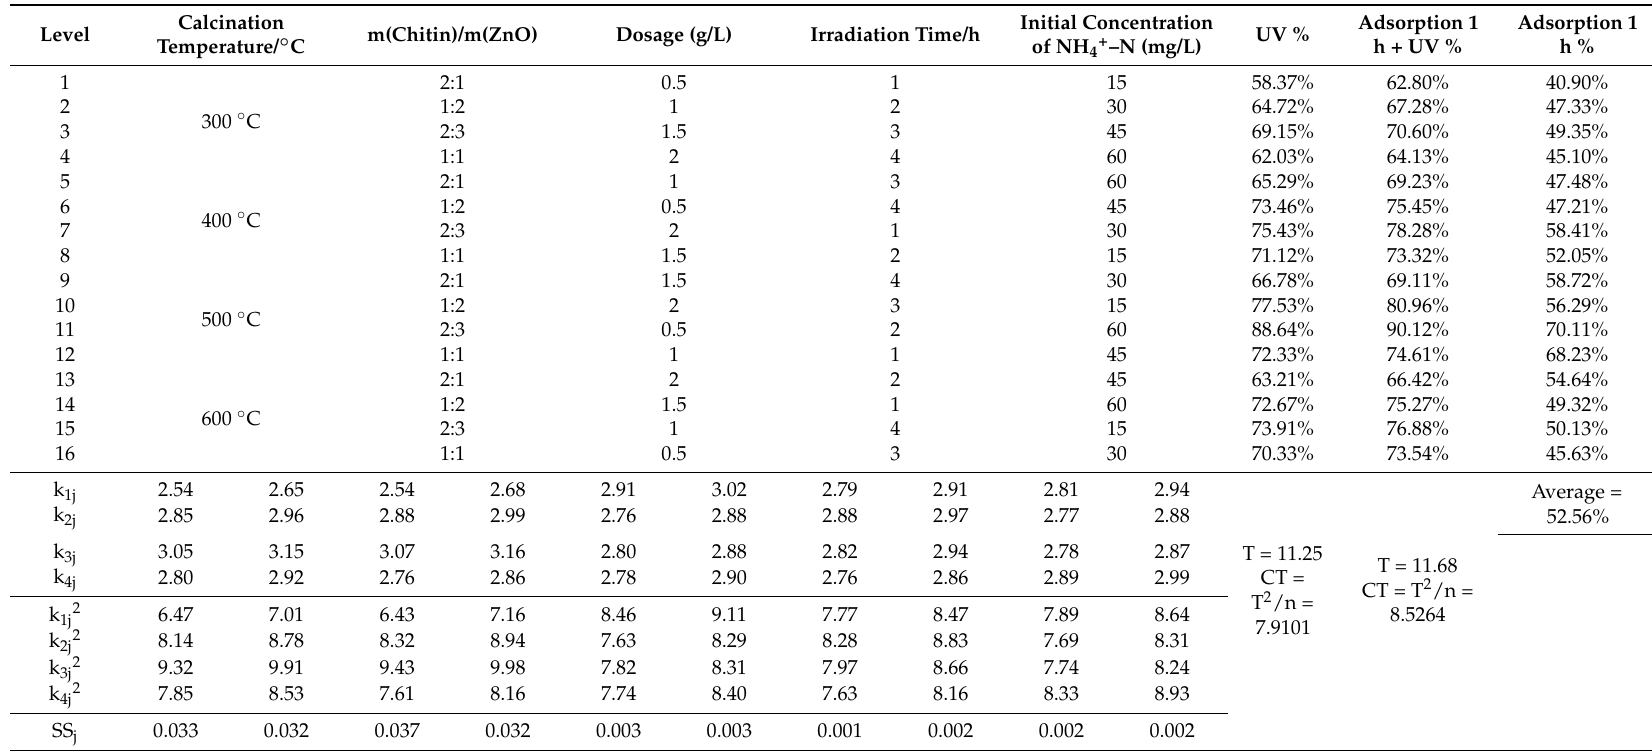
Table 3. The orthogonal test results via five factors and four